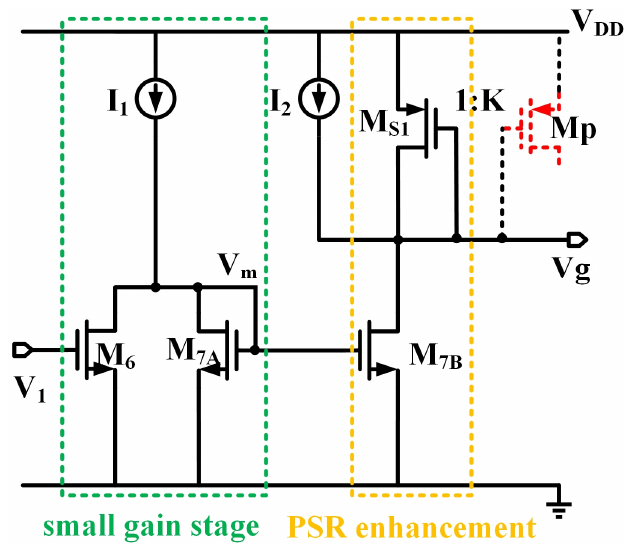
Figure 2. The non-inverting driver stage used in the proposed LDO.